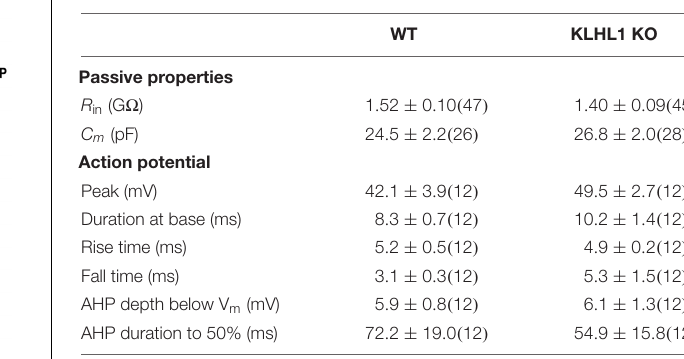
TABLE 1 | Passive and active properties of WT and KLHL-1 KO hypothalamic neurons.